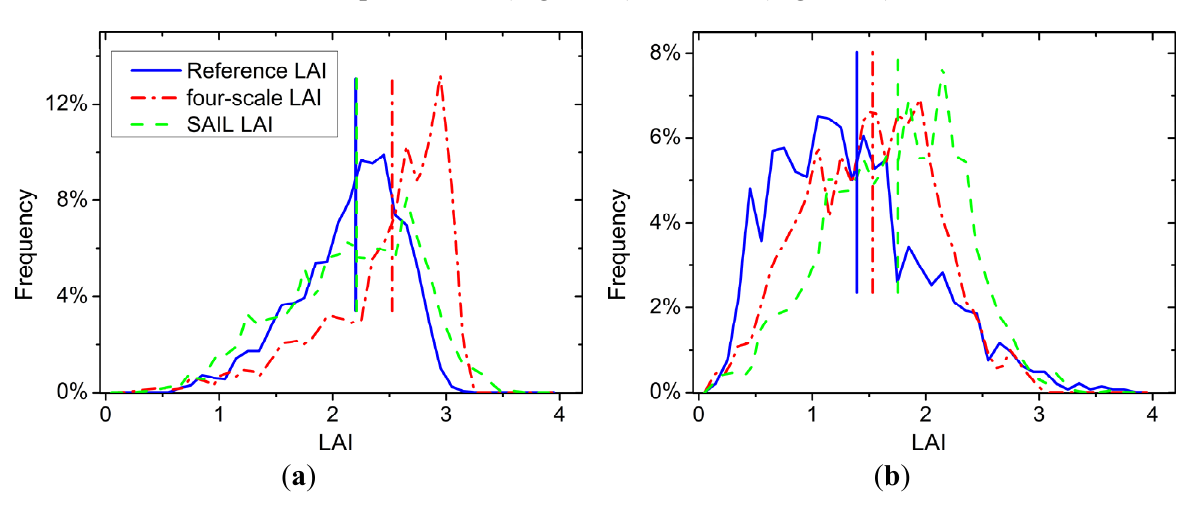
Figure 6. Distribution of the LAI values for each LAI map in AREA ( a ) and FEA ( b ). The solid, dashed and dash-doted vertical bars identify the locations of the mean values for the reference, SAIL and four-scale LAI,